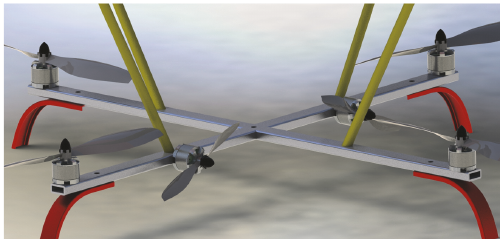
Figure 13: Latest HUAS configuration, with directional propellers.